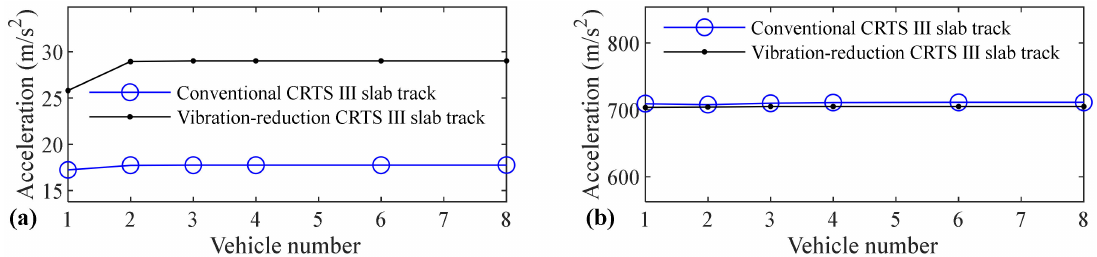
Figure 6. Relation between vehicle number and acceleration of rail: ( a ) without and ( b ) with random track irregularity.